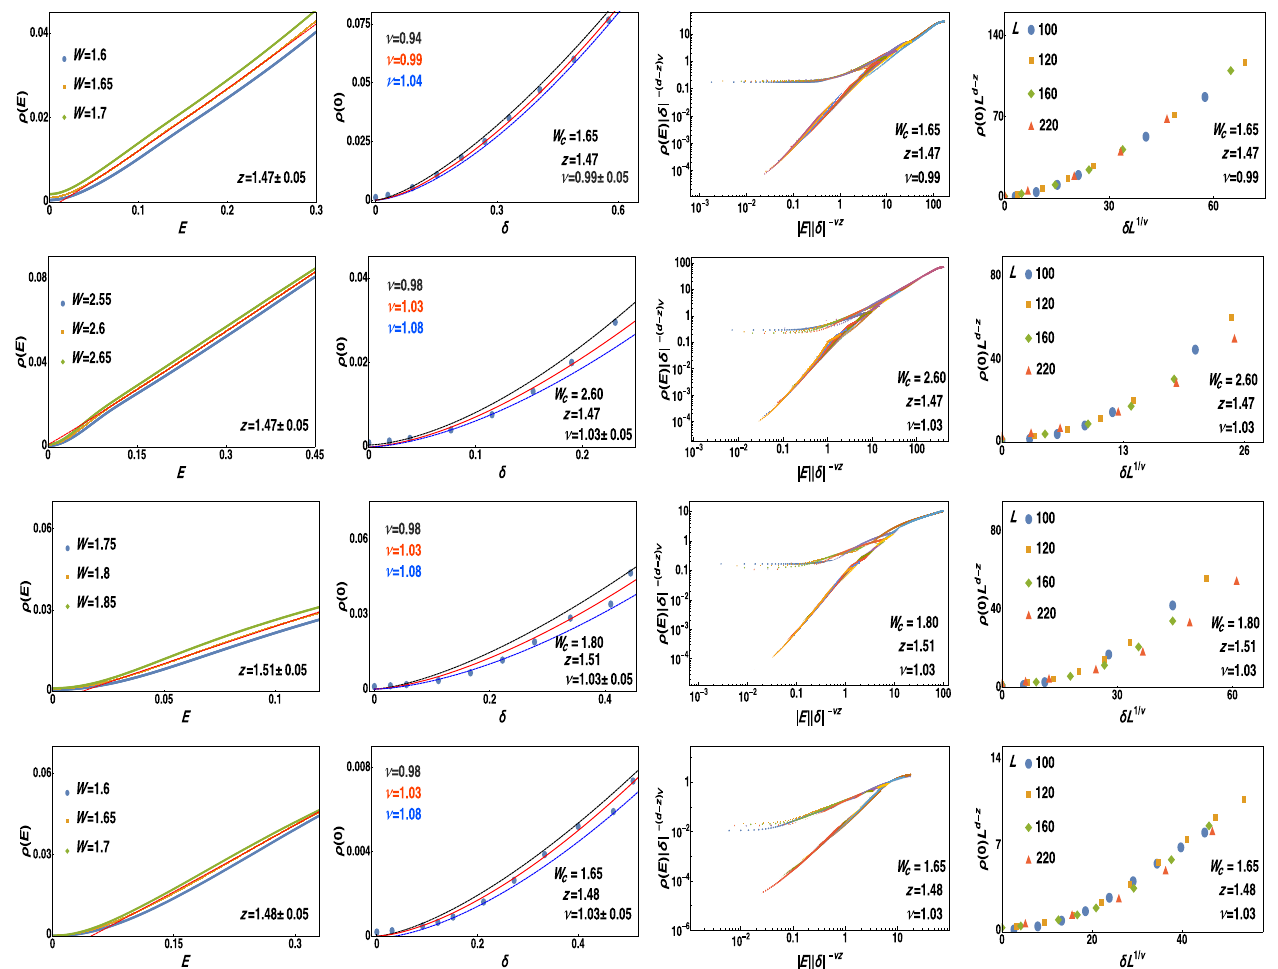
FIG. 13. Scaling analysis of average density of states in various regimes of the phase diagram of a dirty WSM for all four possible intranode scatterings; plots from top to bottom rows correspond to potential ( Δ ( Δ ) disorder. First column shows the scaling of ADOS ϱ ð E Þ versus E around the critical strength of disorder ( W ¼ W C column depicts the scaling of ADOS at zero energy ϱ ð 0 Þ versus δ , the reduced distance from the critical disorder defined as δ ¼ ½ð W − W =W . In the third column we display ϱ ð E Þ δ − ð d − z Þ ν versus j E jj δ j − ν z for weak ( W < W c Þ c (cid:3) and j E j ≪ t ð¼ 1 Þ . All data collapse onto two branches. The top branch represents the metallic phase, while the lower branch represents WSM. Note that these two branches meet at large values of j E jj δ j − ν z , corresponding to the quantum-critical regime. All data in the first three columns are obtained from a system of linear dimension L ¼ 220 . The finite-size data collapse inside the metallic phase is shown in the fourth column, where we compare ϱ ð 0 Þ L d − z versus δ L 1 = ν for 100 ≤ L ≤ 220 . Notice that all data collapse onto one branch for small to moderate values of δ L 1 = ν , with the numerically extracted values of the critical exponents z and ν , quoted in the figure and summarized in Table I. The quality of the data collapse progressively worsens for larger values of δ L 1 = ν due to the existence of a second QPT of a three-dimensional dirty Weyl metal into the Anderson insulating phase, discussed in Sec. IX. Scaling of ADOS and data analysis are discussed in detail in Sec. VI. The quoted error bars in z and ν are fitting error bars. See Appendix E and Table IV (first four rows) for details of data